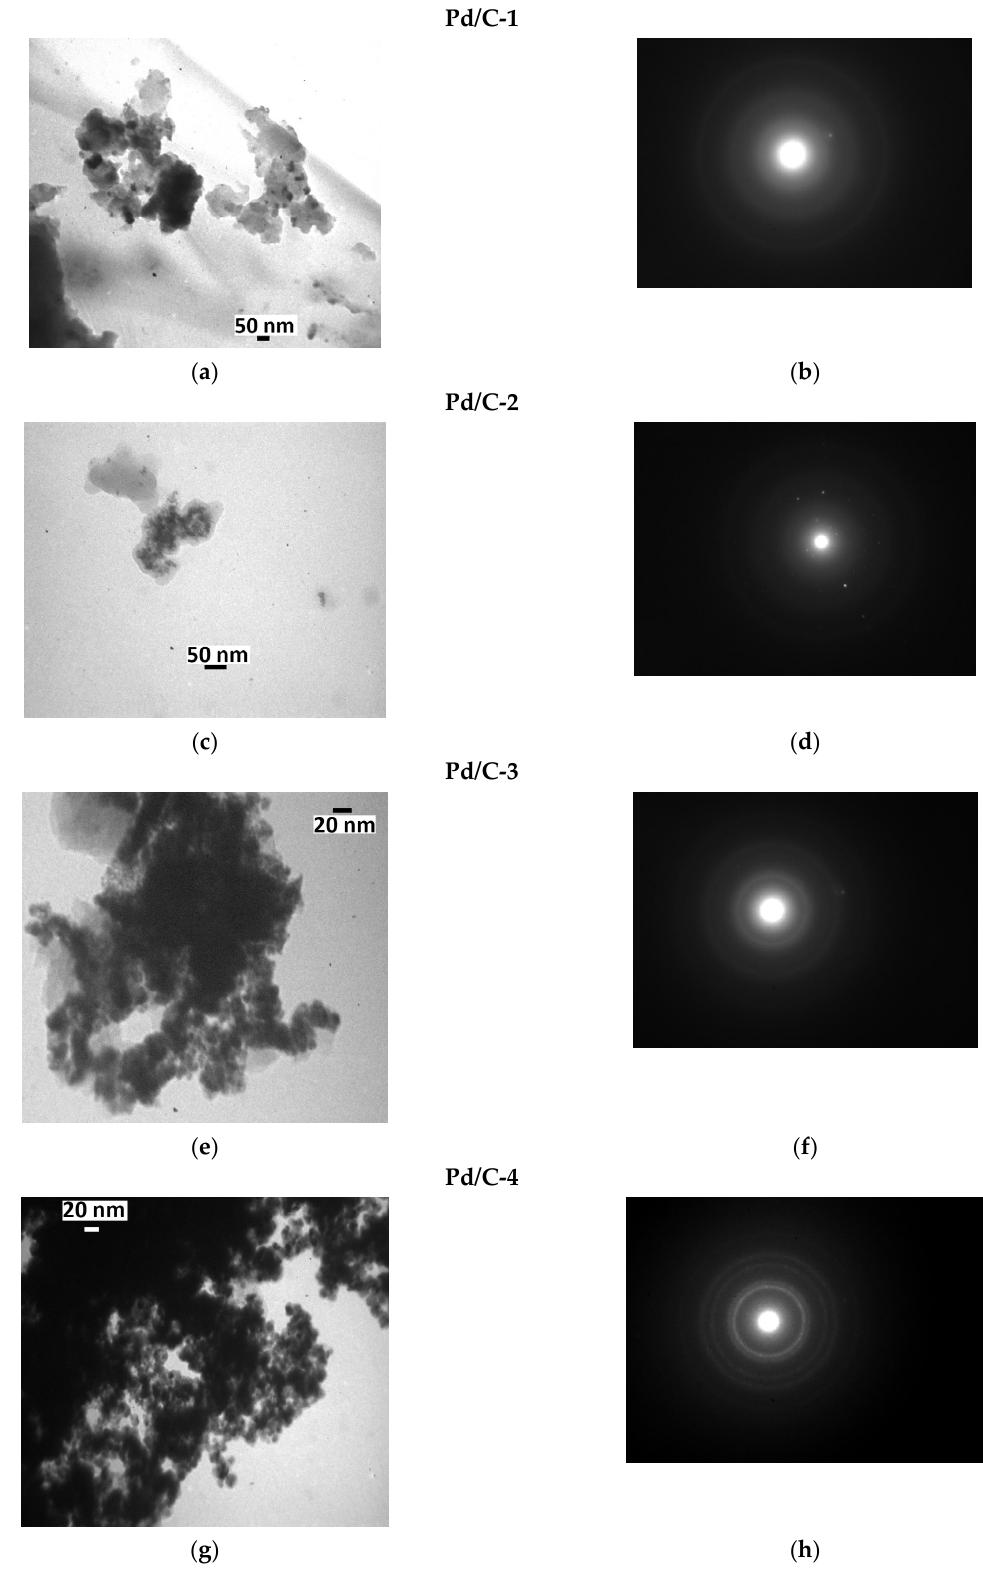
Figure 4. TEM images (left column) and electron diffraction patterns (right column) of Pd/C-1 ( a , b ), Pd/C-2 ( c , d ), Pd/C-3 ( e , f ), and Pd/C-4 ( g , h ) composites.